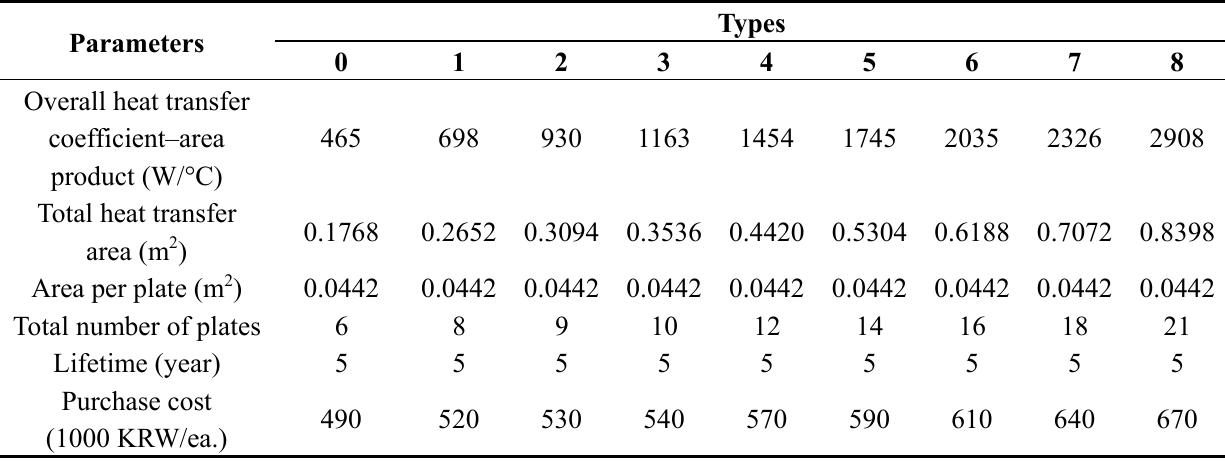
Table A3. Technical and economic parameters of the heat exchangers for each case.